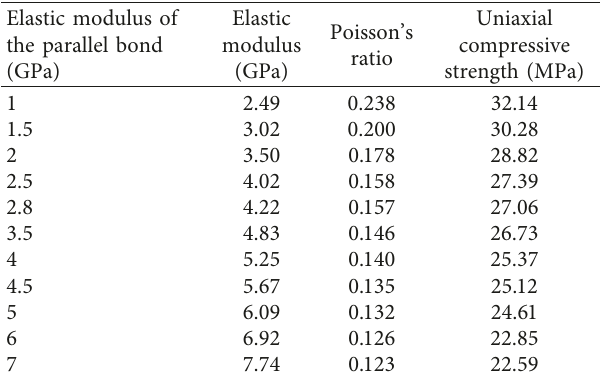
T ABLE 6: Relation between the macromechanical properties with different elastic moduli of the parallel